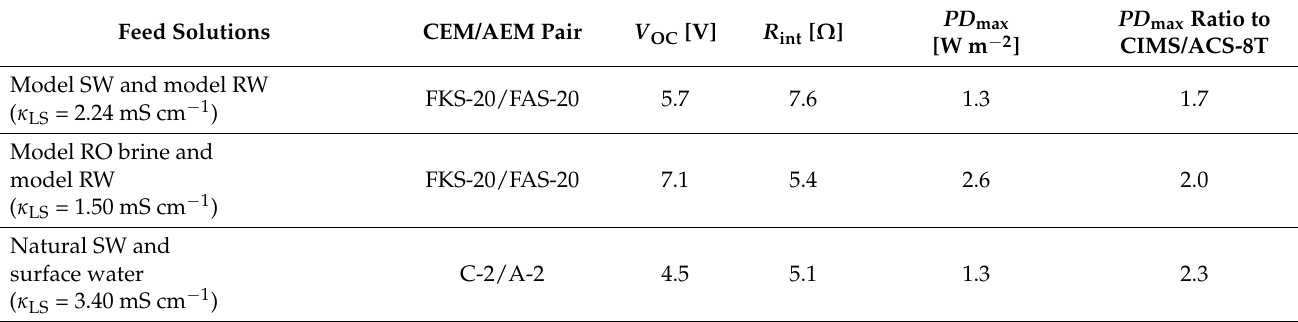
Table 3. Summary of the best performance of the lab-scale RED stack in this study (40 membranes pairs, 200 µ m inter-membrane distance, and 7040 cm 2 total effective membrane area).